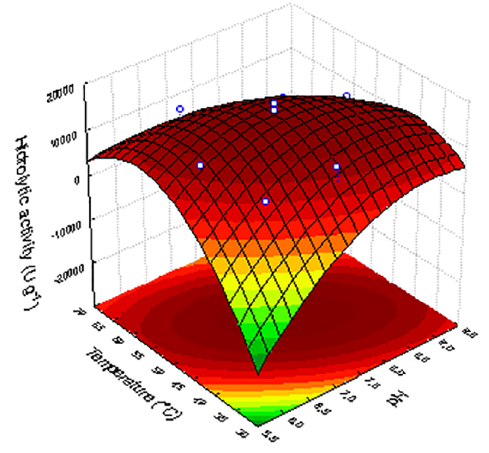
Figure 7. As expected, the immobilization process stabilized Table 4. Analysis of variance of the model that represents the hydrolytic activity of free lipase as function of pH (X Source